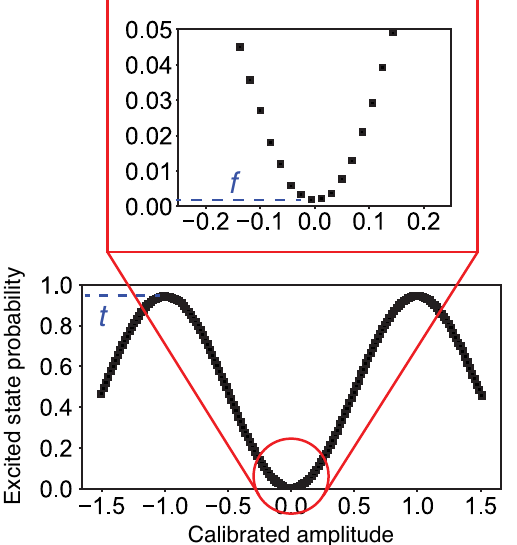
FIG. 9. Calibration of systematic measurement errors using selective ancilla pulses. A standard Rabi calibration experiment of a selective pulse used for measurement (here shown for ancilla B ). The maximum probability t is limited by decoherence of the transmon during both the pulse and the readout. The floor f is set by the probability of heating out of the ground state during both the pulse and the